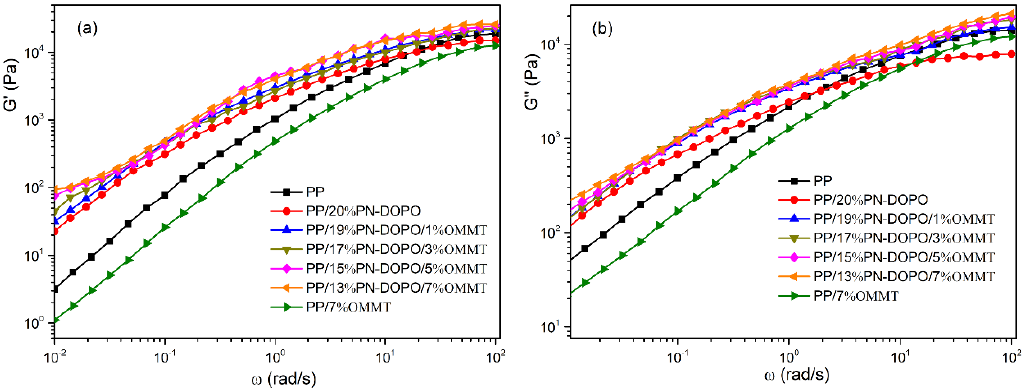
Figure 7. Storage modulus ( a ) and loss modulus ( b ) versus frequency of PP and flame-retarded PP composites.